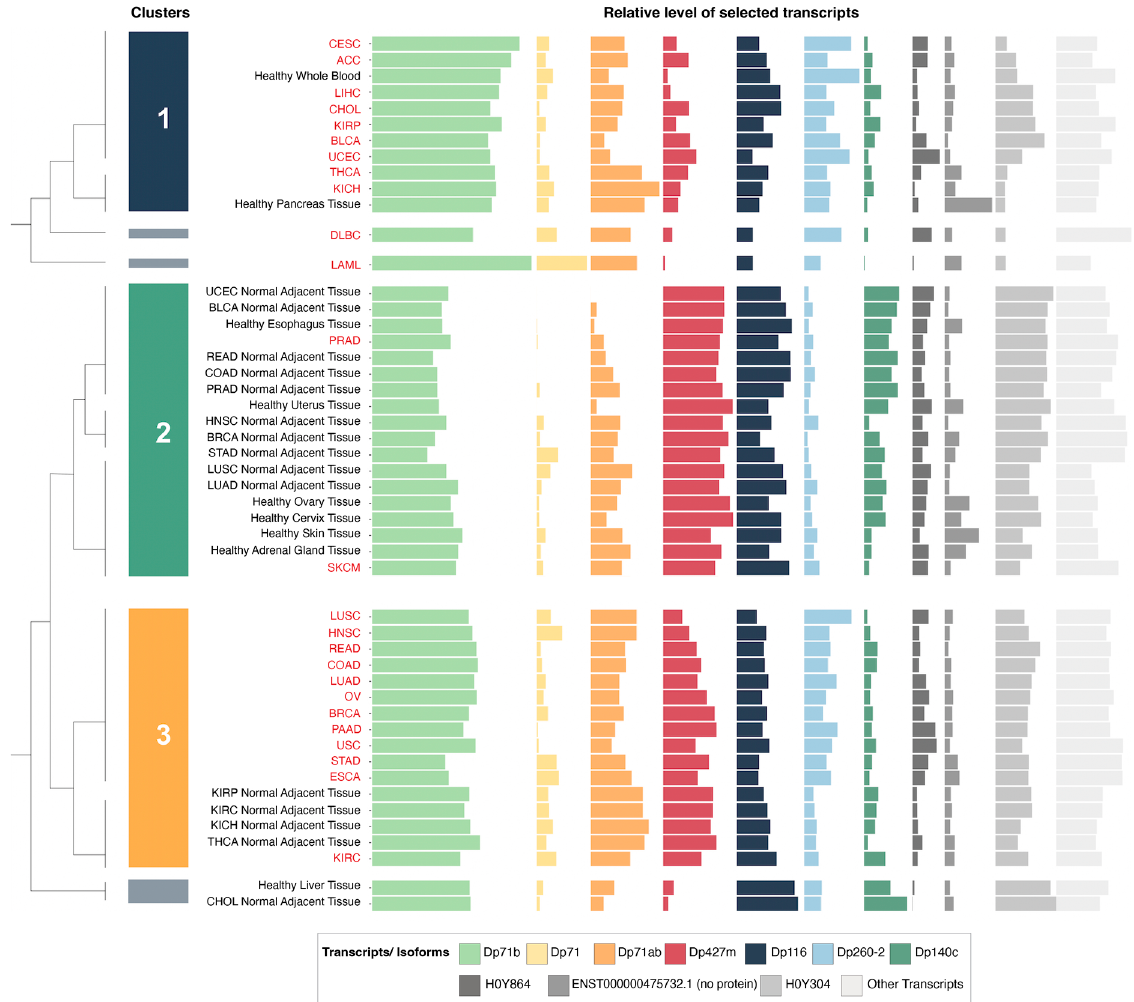
Figure 2. Bar plots representing the relative expression levels of the top 10 highly expressed DMD transcripts in tumor (text in red) and control tissues (text in black) and a dendrogram displaying the clusters identified by the hierarchical clustering analysis. Abbreviations: CESC (cervical and endocervical cancer), ACC (adrenocortical carcinoma), LIHC (liver hepatocellular carcinoma), CHOL (cholangiocarcinoma), KIRP (kidney papillary cell carcinoma), BLCA (bladder urothelial carcinoma), UCEC (uterine corpus endometrioid carcinoma), THCA (thyroid carcinoma), KICH (kidney chromophobe cell carcinoma), DLBC (diffuse large B-cell lymphoma), LAML (acute myeloid leukemia), PRAD (prostate adenocarcinoma), HNSC (head and neck squamous cell carcinoma), LUSC (lung squamous cell carcinoma), LUAD (lung adenocarcinoma), SKCM (skin cutaneous melanoma), READ (rectal adenocarcinoma), COAD (colon adenocarcinoma), OV (ovarian serous cystadenocarcinoma), BRCA (breast invasive carcinoma), PAAD (pancreatic adenocarcinoma), USC (uterine carcinosarcoma), STAD (stomach adenocarcinoma), ESCA (esophageal carcinoma), KIRC (kidney clear